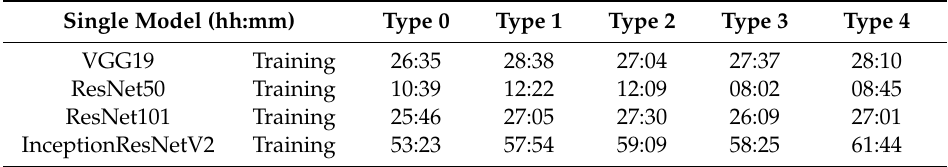
Table12. Trainingtimeofasinglemodelfor11classeswithoutaugmentationundernontransferlearning. Single Model